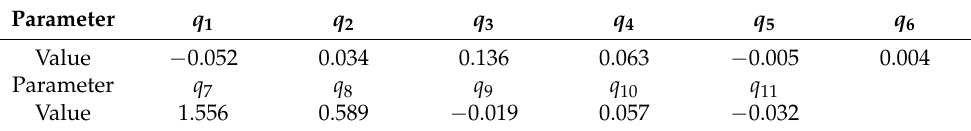
Table 6. Fitting results of the damping coefficient c 2